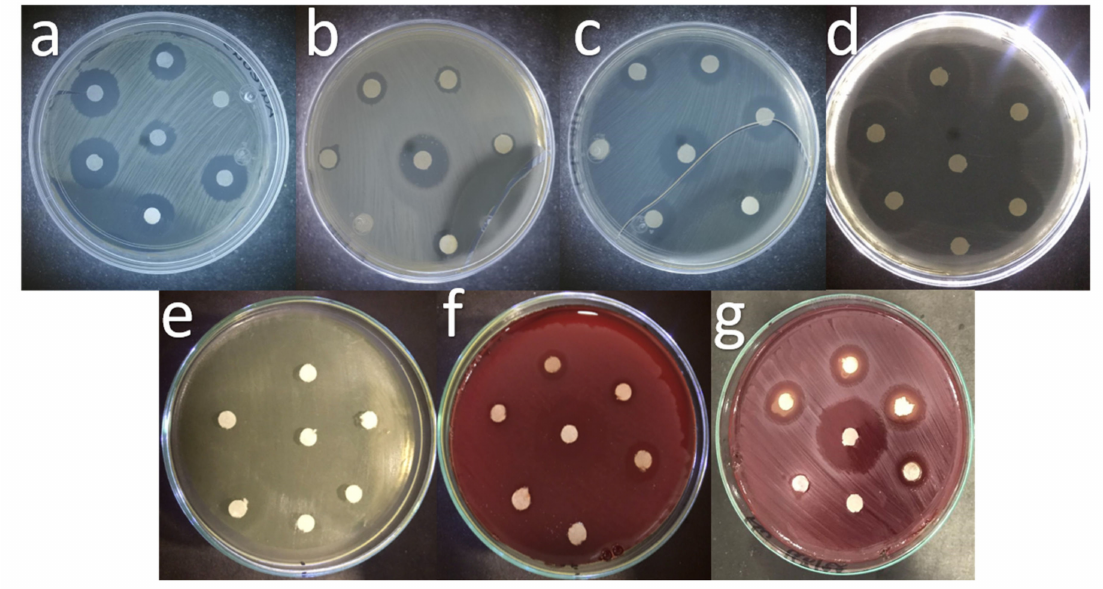
Figure 10. Antibiograms of the evaluated treatments, ( a ) E. coli , ( b ) E. faecalis , ( c ) S. Aureus , ( d ) S. mutans , ( e ) A. odontolyticus , ( f ) V. parvula , ( g ) F.